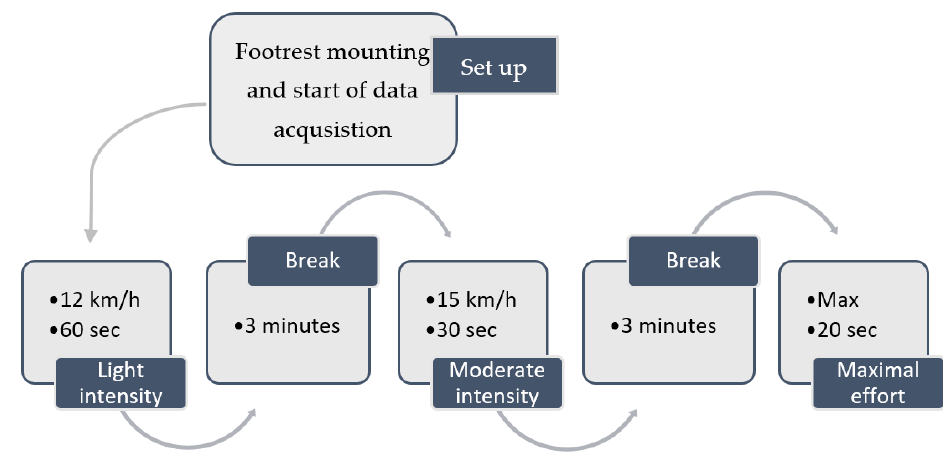
Figure 2. An overview of the workflow of data acquisition